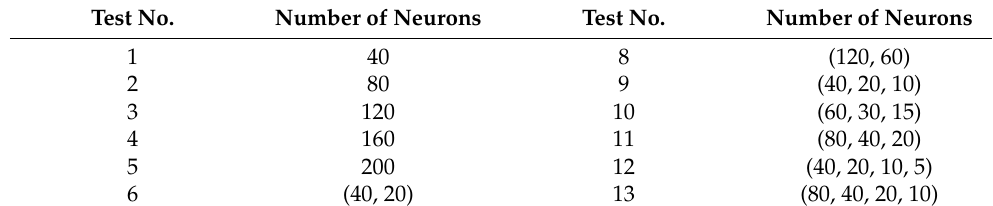
Table 2. Units and corresponding symbols.